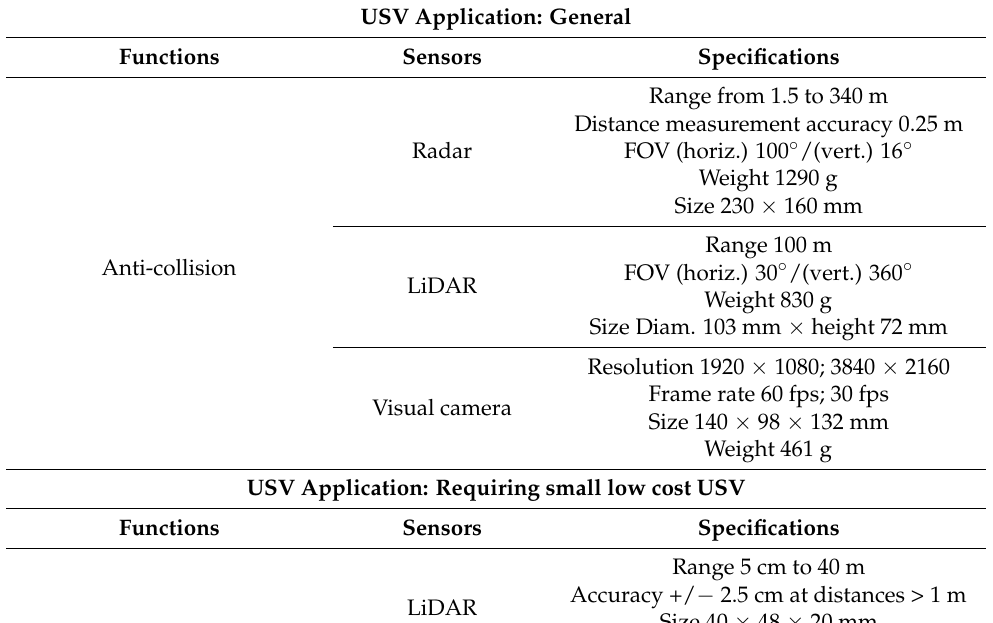
Table 6. Some examples of USV sensor application